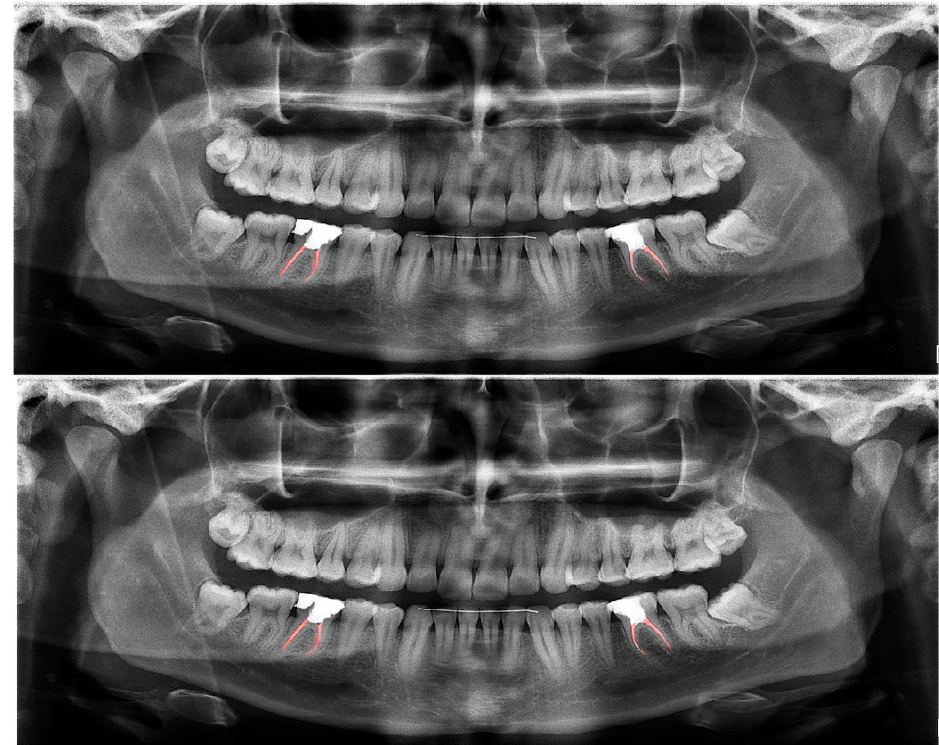
Figure 6. Automatic segmentation of root-canal fillings. Manual segmentation ( upper image ) and automatic segmentation ( lower image ) can be seen above.